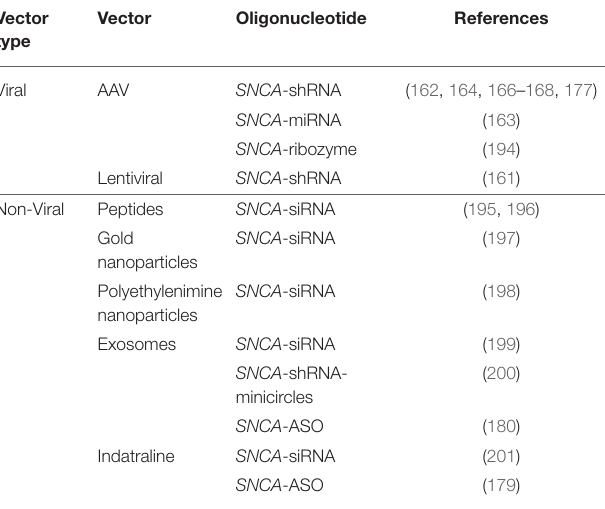
TABLE 2 | Delivery vectors for asyn targeted gene therapy. Vector